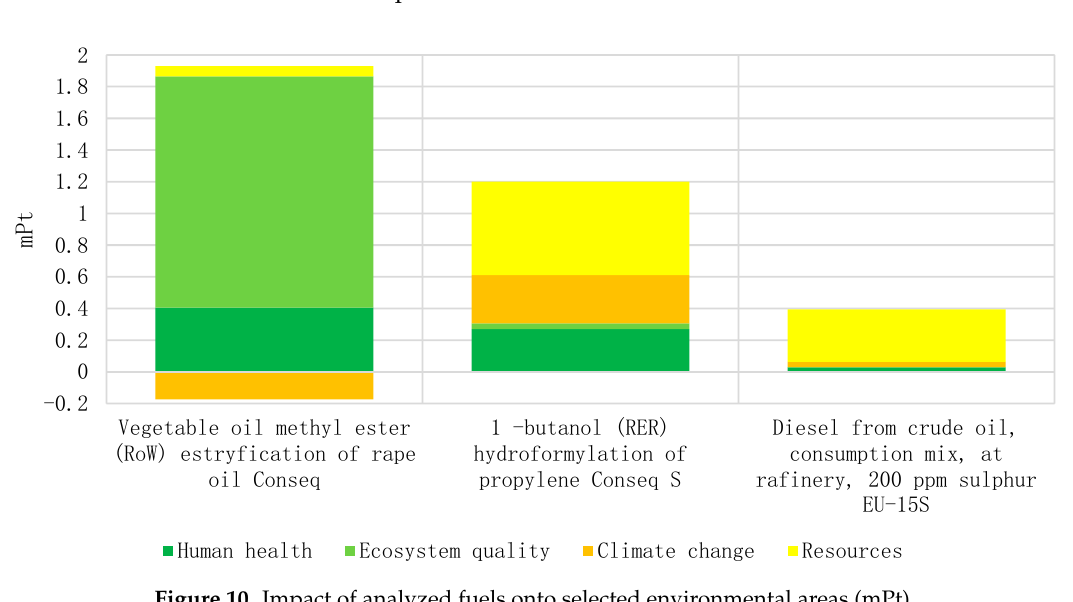
Figure 10. Impact of analyzed fuels onto selected environmental areas (mPt).